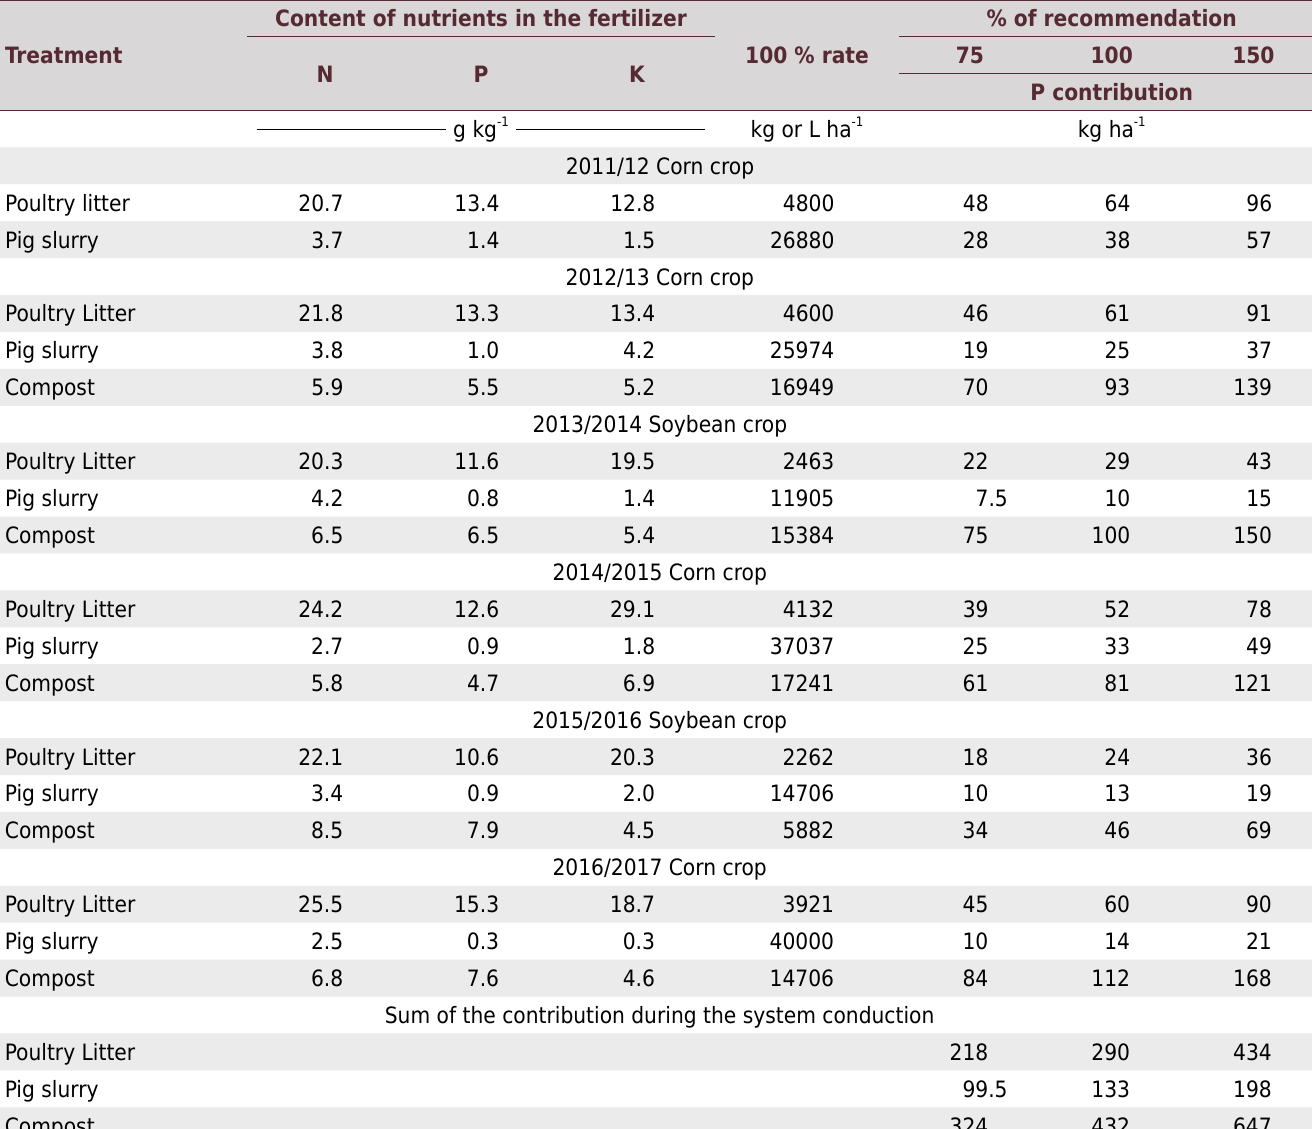
Table 2. Contribution of nutrients in the organic fertilizers applied in the iCL system Content of nutrients in the fertilizer Treatment